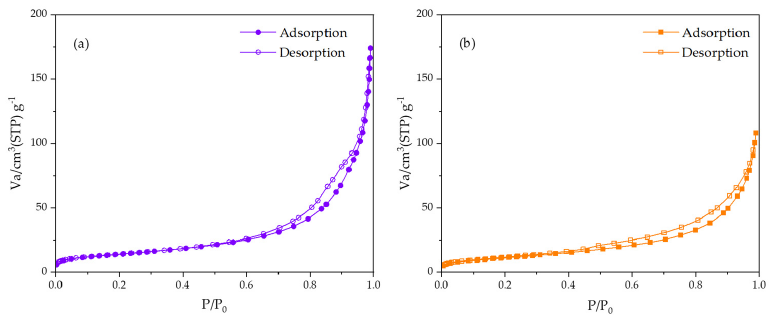
Figure 8. Nitrogen adsorption–desorption isotherms of nHAp powder ( a ) 1DP − nHAp and ( b ) 2DP − nHAp. TGA analysis was used to confirm the composition of HAp in 1DP − nHAp and